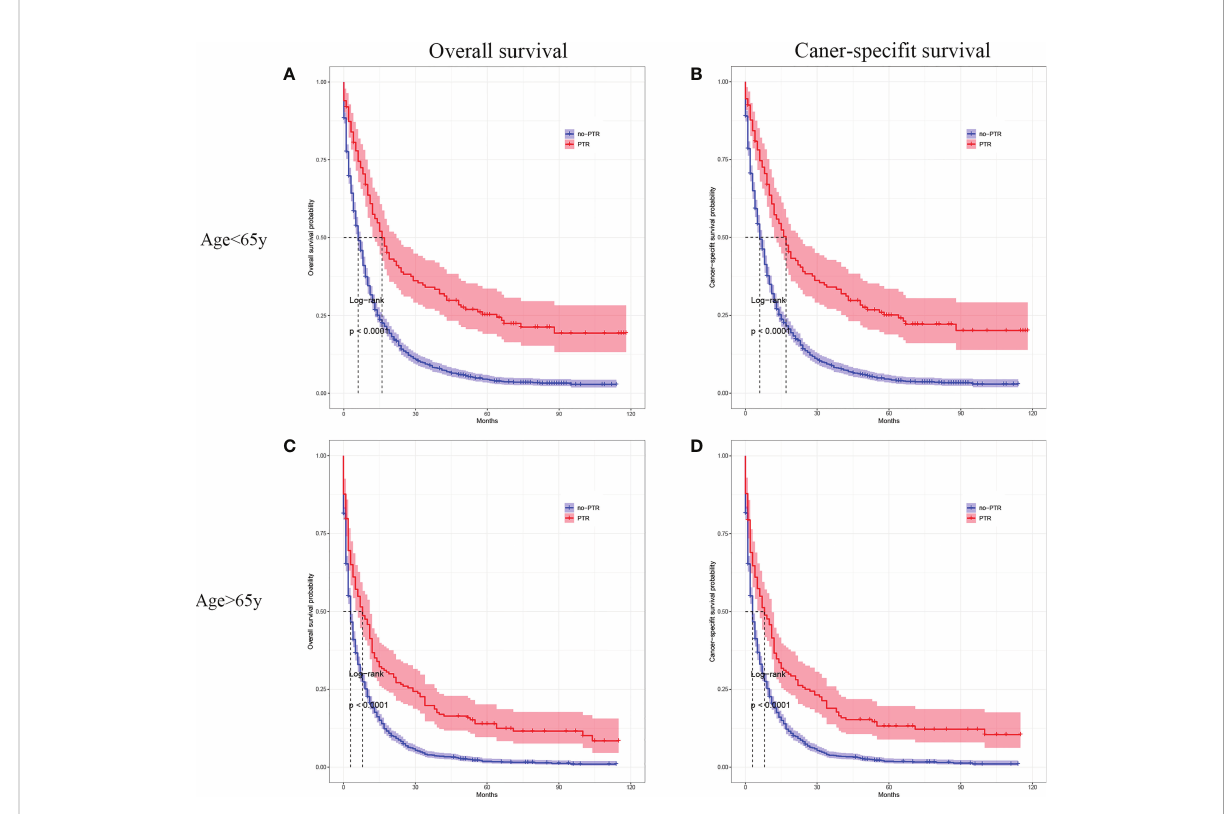
FIGURE 3 Kaplan – Meier curves for overall survival and carcinoma-speci fi c survival of patients with primary tumor resection versus without primary tumor resection strati fi ed by age in the unmatched